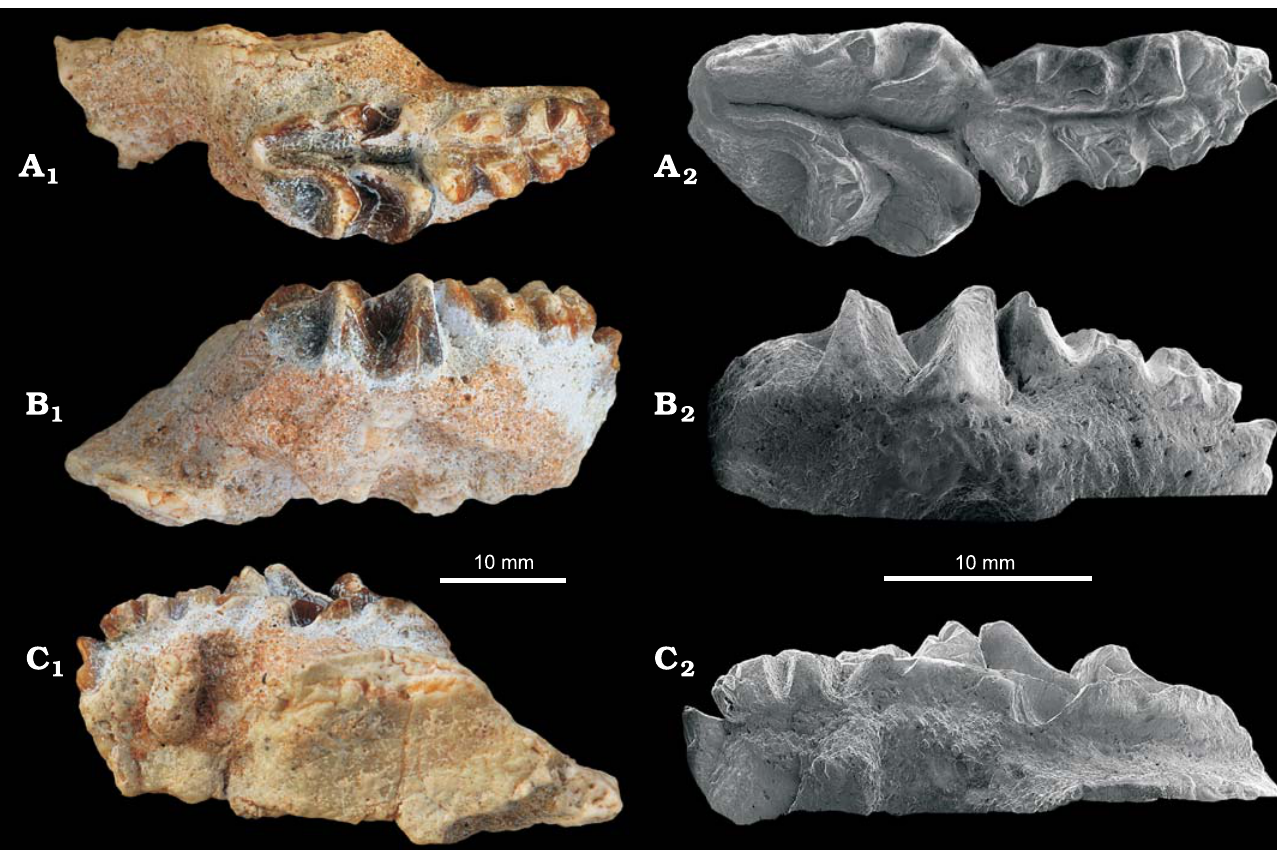
Fig. 7. Multituberculate mammal Sphenopsalis nobilis Matthew, Granger, and Simpson, 1928 (IVPP V19032) from the upper Paleocene Nomogen beds at the Erden (Urtyn) Obo locality, Inner Mongolia, China. Left lower cheek teeth (p4–m2) from the same individual as in Fig. 5 in occlusal ( A ), medial ( B ), and lateral ( C ) views. Photographs (A 1 –C 1 ), SEM images (A 2 –C 2